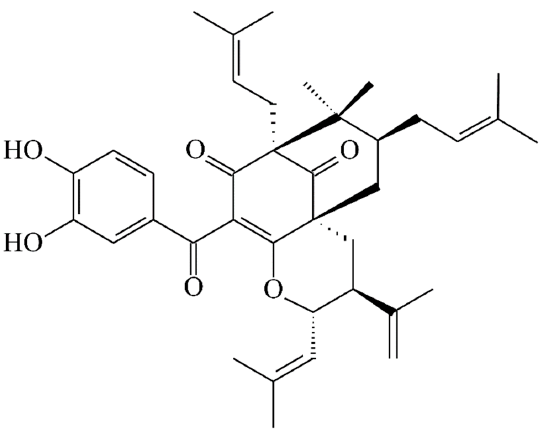
Figure 2. The chemical structure of garcicowin C. Figure 5. The chemical structure of isoxanthochymol.